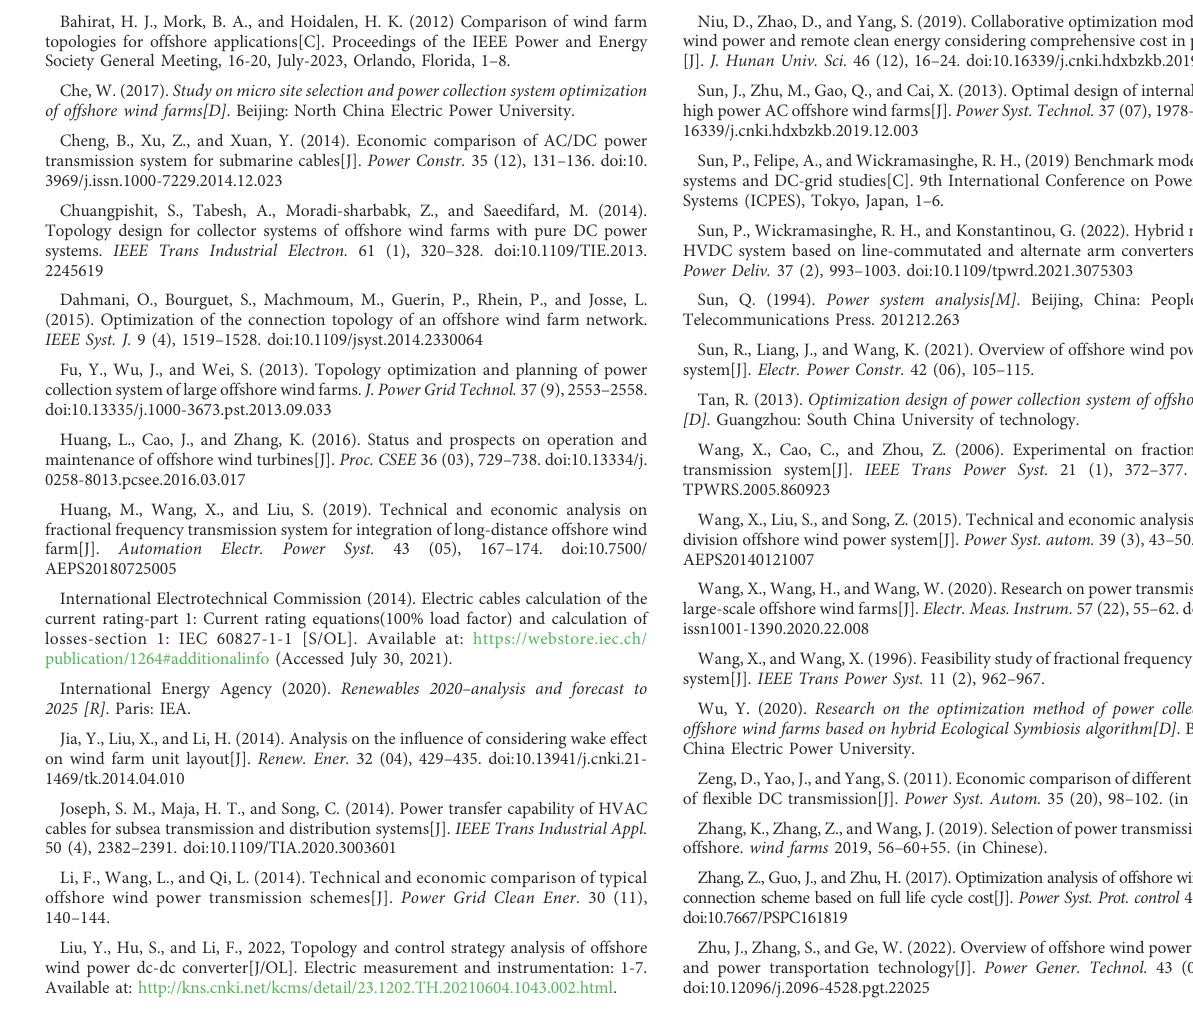
SUPPLEMENTARY TABLE S6 Location information of wind farm and substation. SUPPLEMENTARY TABLE S7 Planning scheme I route selection. SUPPLEMENTARY TABLE S8 Planning scheme II route selection. SUPPLEMENTARY TABLE S9 Planning scheme III route selection.